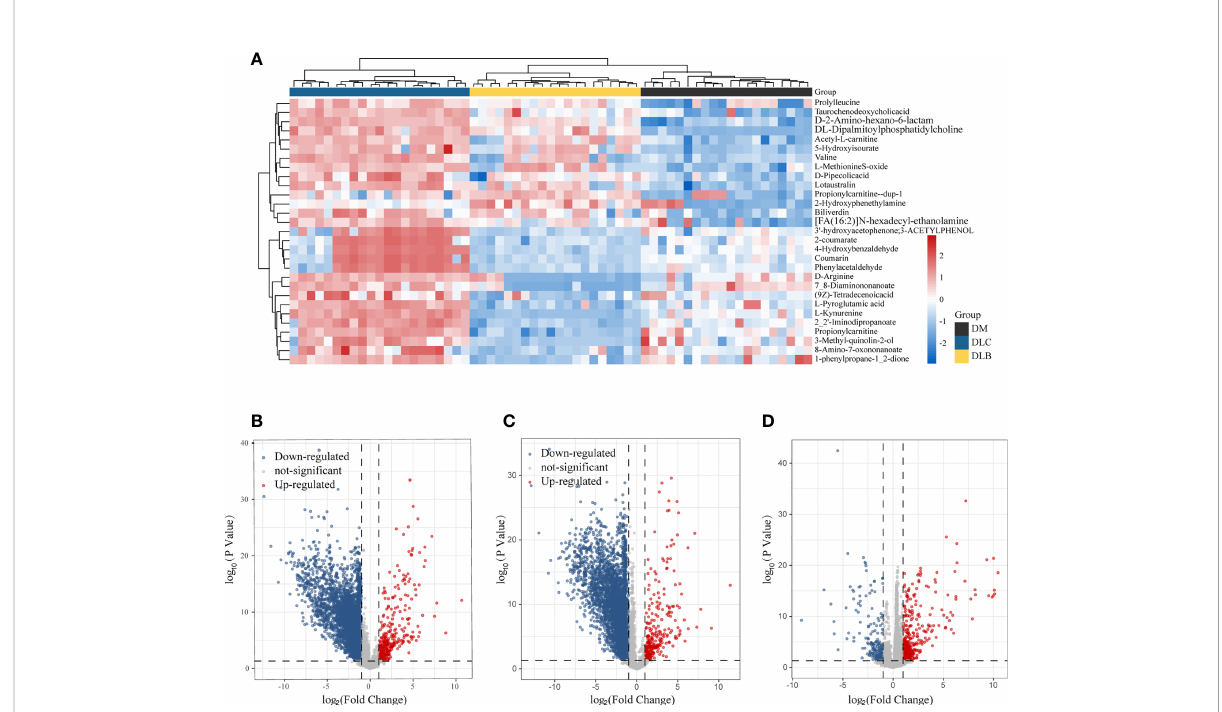
FIGURE 3 Differential metabolities, The heatmap illustrating the levels of DEMs among the three groups (A) , Volcano plot showing the DEMSs between DLC and DM (B) , the DEMs between DLB and DM (C) , THE demS between DLC and DLB (D) .